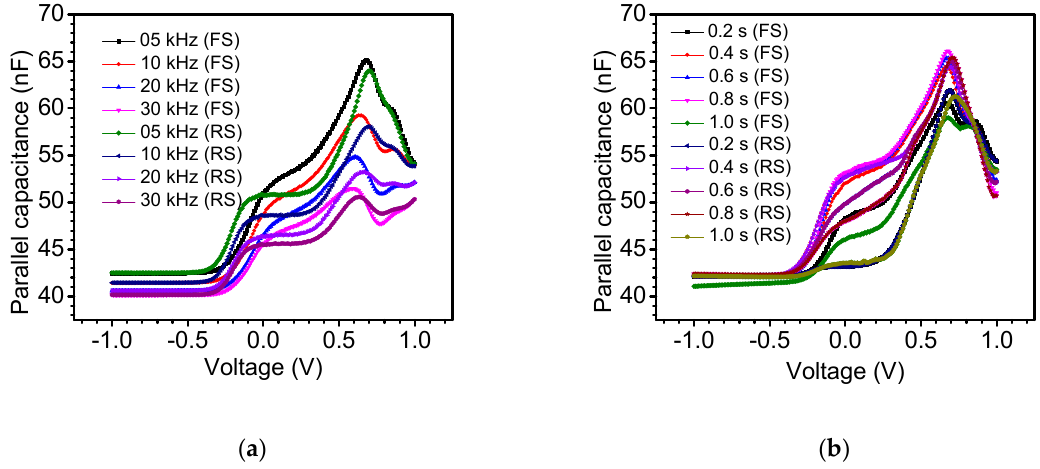
Figure 3. Parallel capacitance–voltage ( C P –V ) curves recorded on the device in the dark at forward scan (FS: scan direction from − 1 to 1 V) and reverse scan (RS: scan direction from 1 to − 1 V) ( a ) at different frequencies and a time delay of 0.2 s, and ( b ) at different time delays and a frequency of 5 kHz.